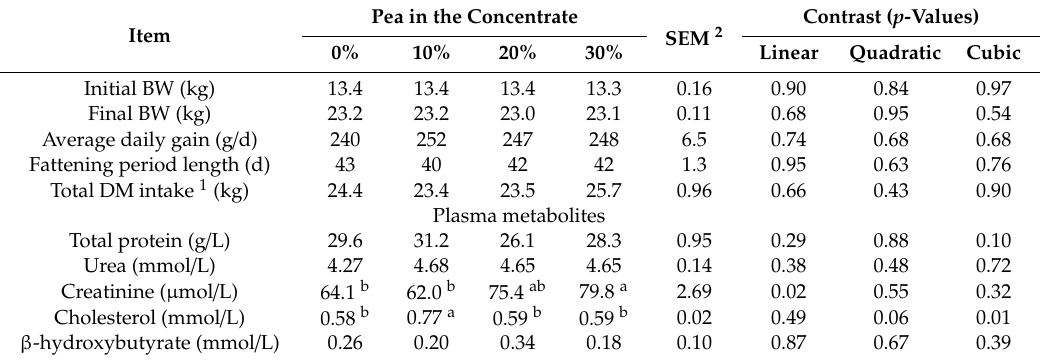
Table 5. E ff ect of the inclusion of pea in the concentrate on the performance during the fattening period and on the plasma metabolites of lambs at slaughter (performance